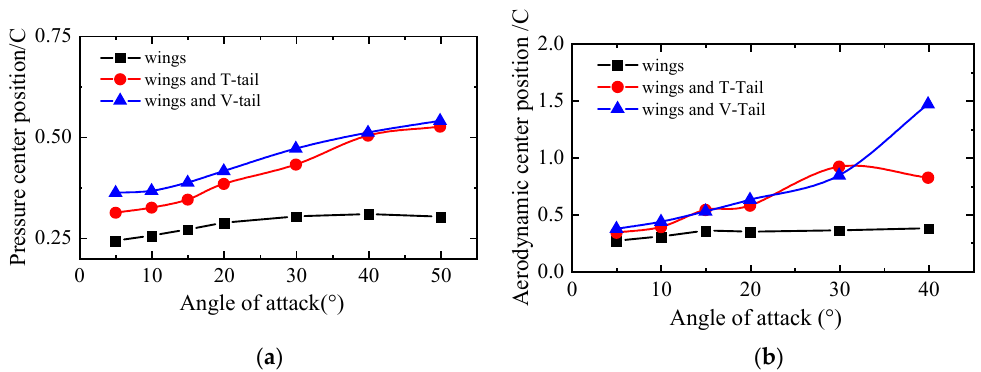
Figure 15. Pressure center and aerodynamic center move with the angle of attack. ( a ) Pressure center position. ( b ) Aerodynamic center position.